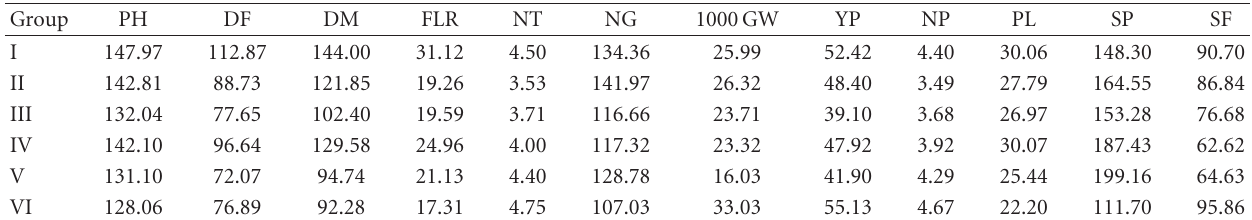
Table 8: Mean value of 12 quantitative traits for six groups by cluster analysis on 50 upland rice accessions.